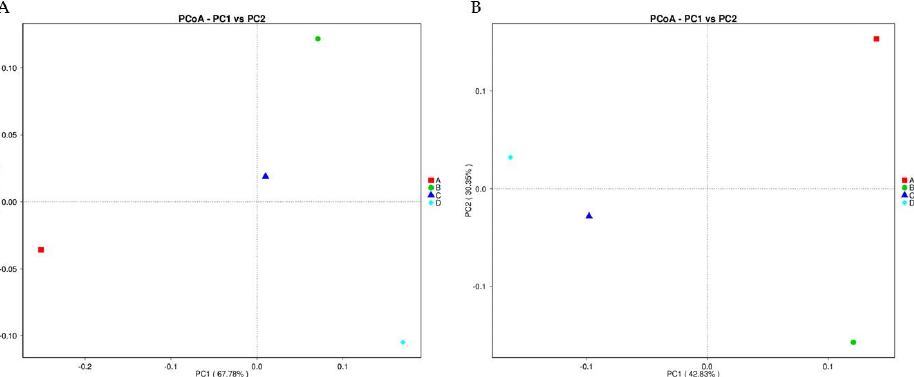
Figure 9. ( A ) PCoA based on Weighted Unifrac distance. ( B ) PCoA based on Unweighted Unifrac distance (A, A1 thermophilic of Harmanli site; B, A2 mesophilic of Harmanli site; C, B1 mesophilic of Yasno pole site; D, B2 thermophilic of Yasno pole site).